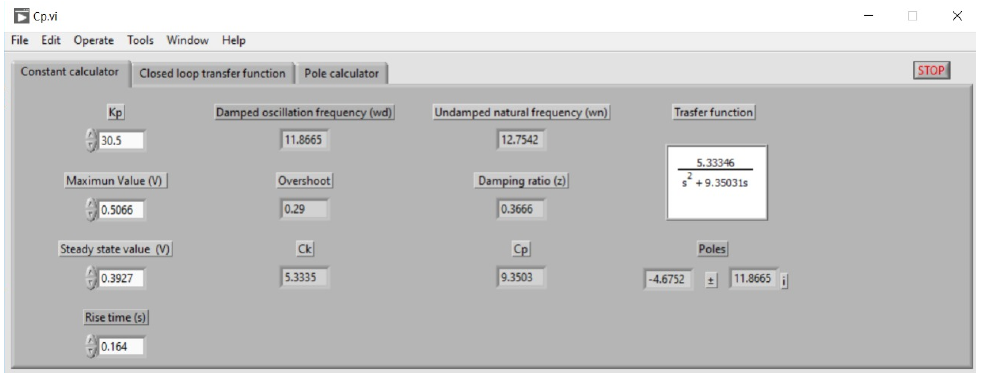
Figure 9. Graphical interface of the DC motor constants